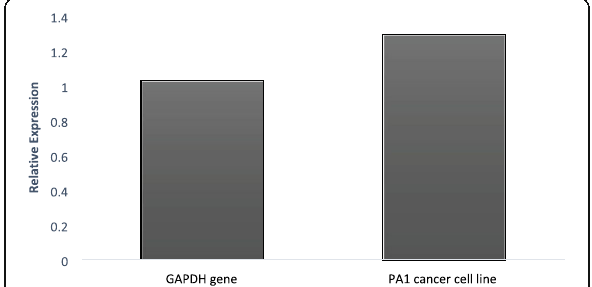
Fig. 6 Relative expression of p53 compared to GAPDH gene on the control and treated sample of PA1 cancer cell